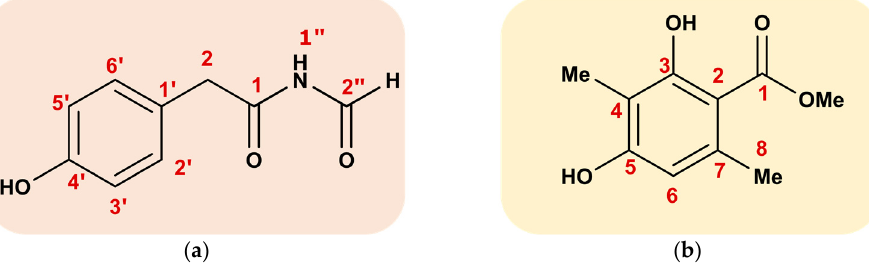
Figure 3. ( a ) Chemical structure of N-formyl-4-hydroxyphenyl-acetamide 1 , ( b ) chemical structure of atraric acid 2 .